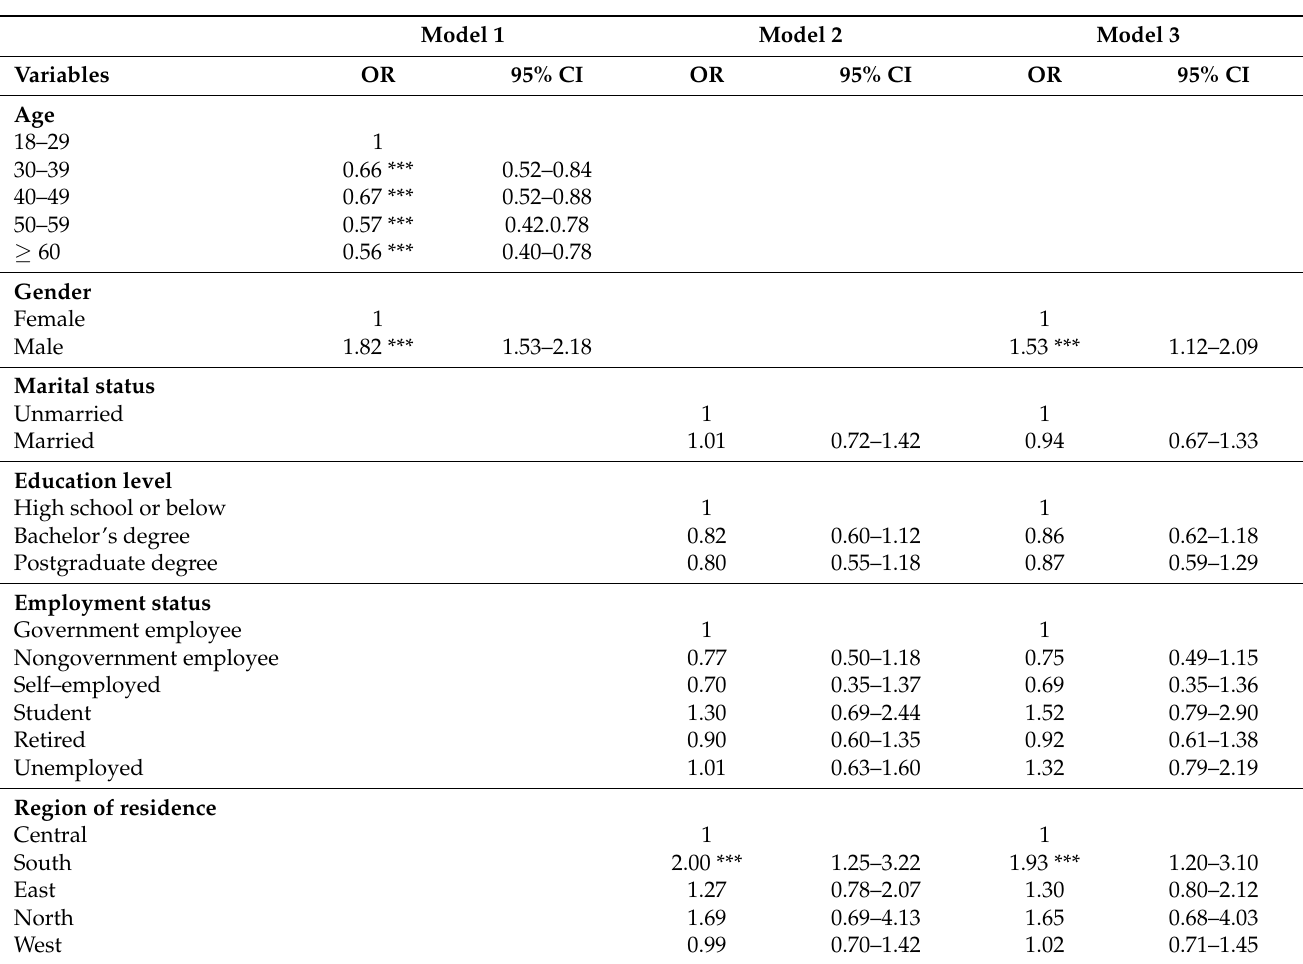
Table A1. Adjusted odds ratios for logistic regression estimates of factors associated with COVID-19 vaccine